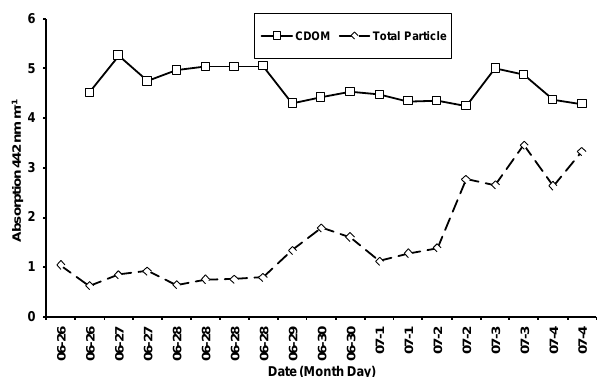
Fig. 3. CDOM and total particle absorption variability at 442nm during the sampling